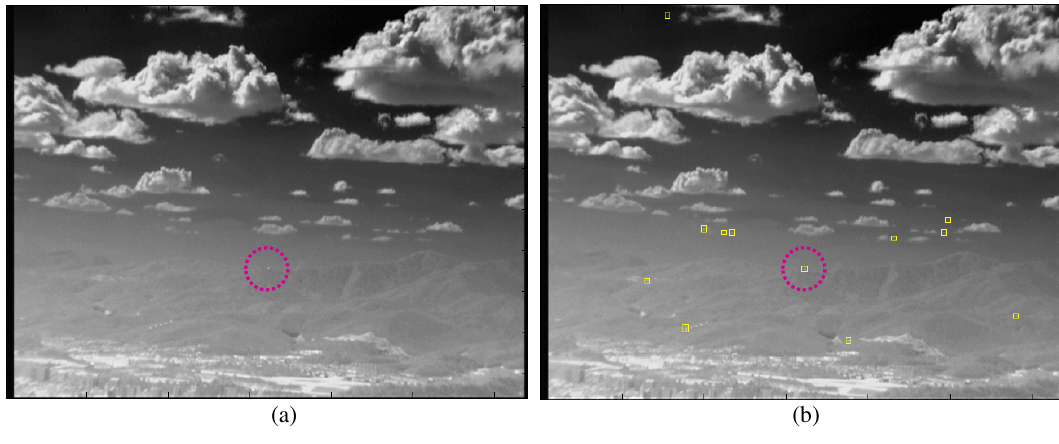
Figure 13. Example of stationary target candidate detector: ( a ) incoming target in line of sight (LOS); ( b ) stationary target detection results.